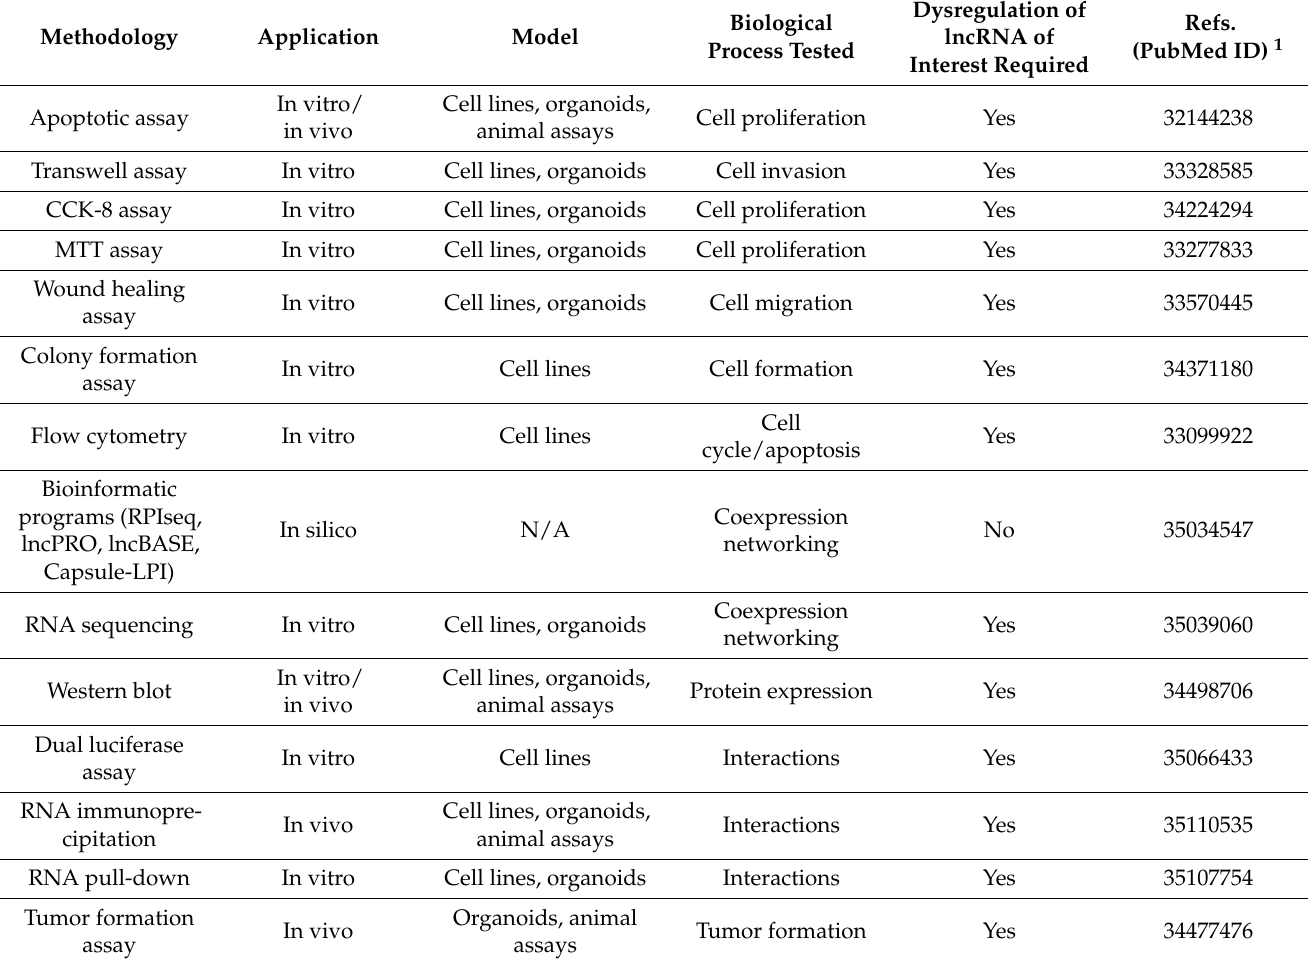
Table 1. Methods for determining lncRNA-dependent phenotypes of